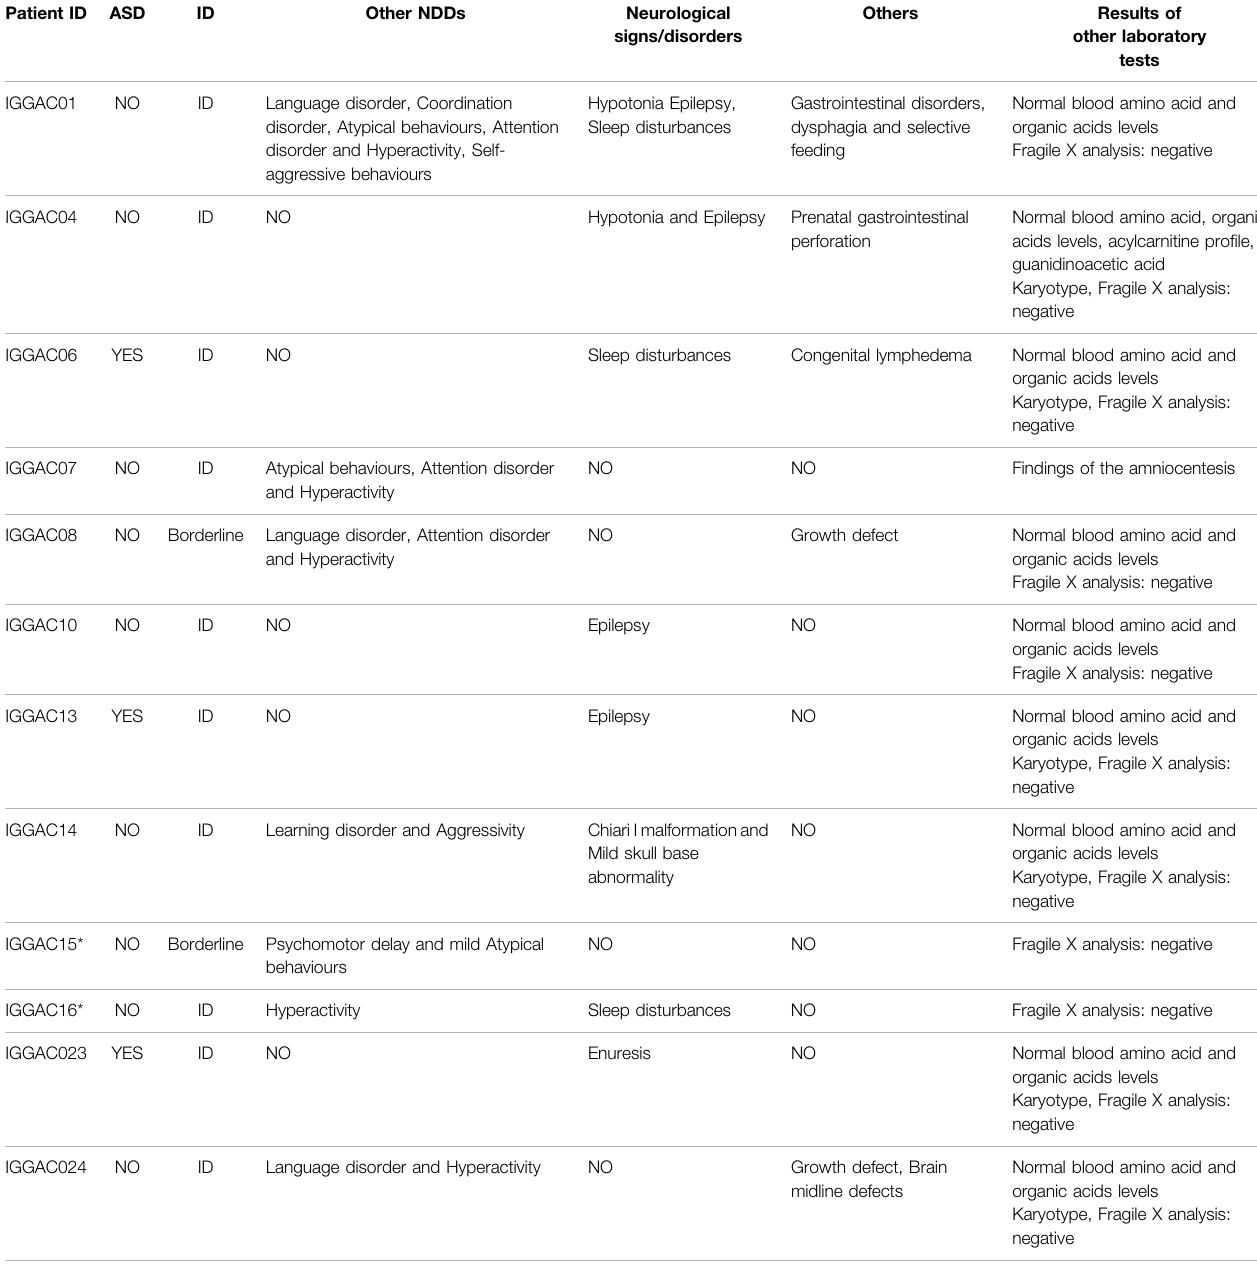
TABLE 1 | Clinical